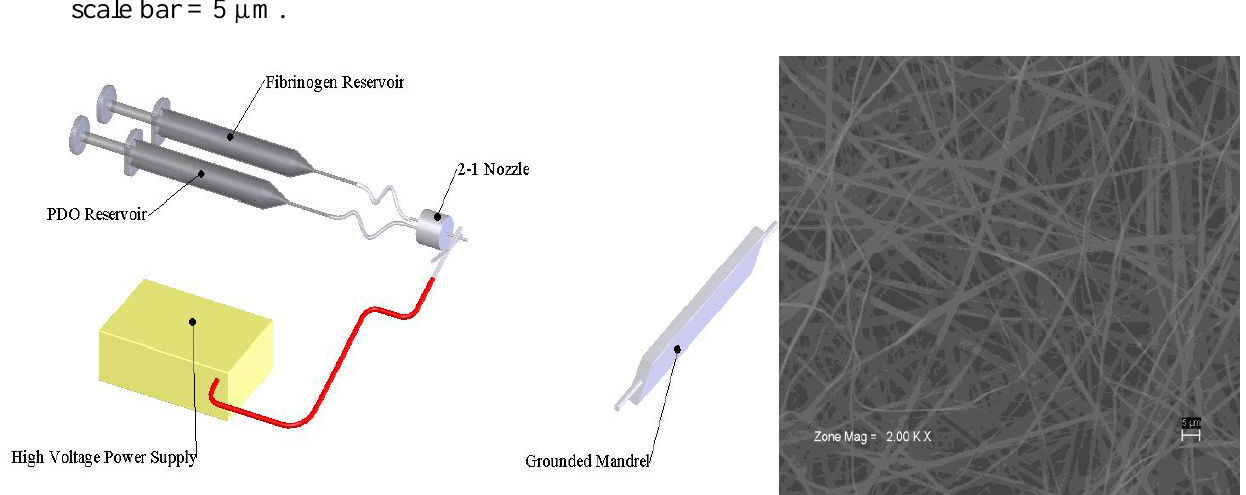
Figure 8. Electrospinning setup of fibrinogen and PDO scaffolds using a novel 2-1 nozzle (Left) and SEM of a 50:50 PDO:fibrinogen blended scaffold. Image at 2000×, scale bar = 5